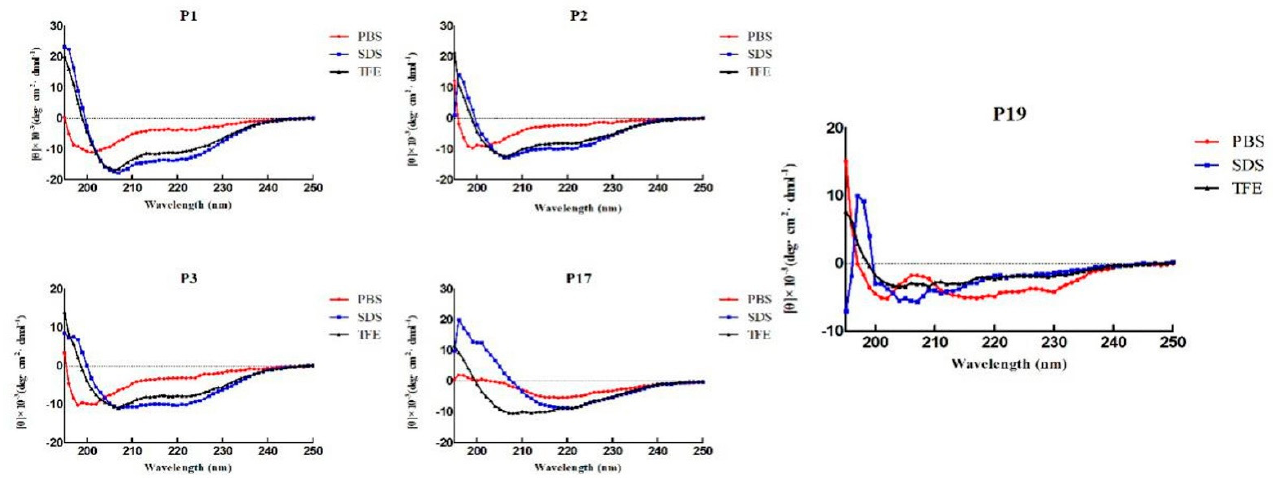
Figure 3. The CD spectra of the peptides. The peptides were dissolved in 10 mM sodium phosphate buffer (pH 7.4), 50% trifluoroethanol (TFE) and 30 mM sodium lauryl sulfate (SDS). The mean residue ellipticity was plotted against the wavelength. The values from the three scans were averaged per sample, and the peptide concentrations were fixed at 150 μ M.